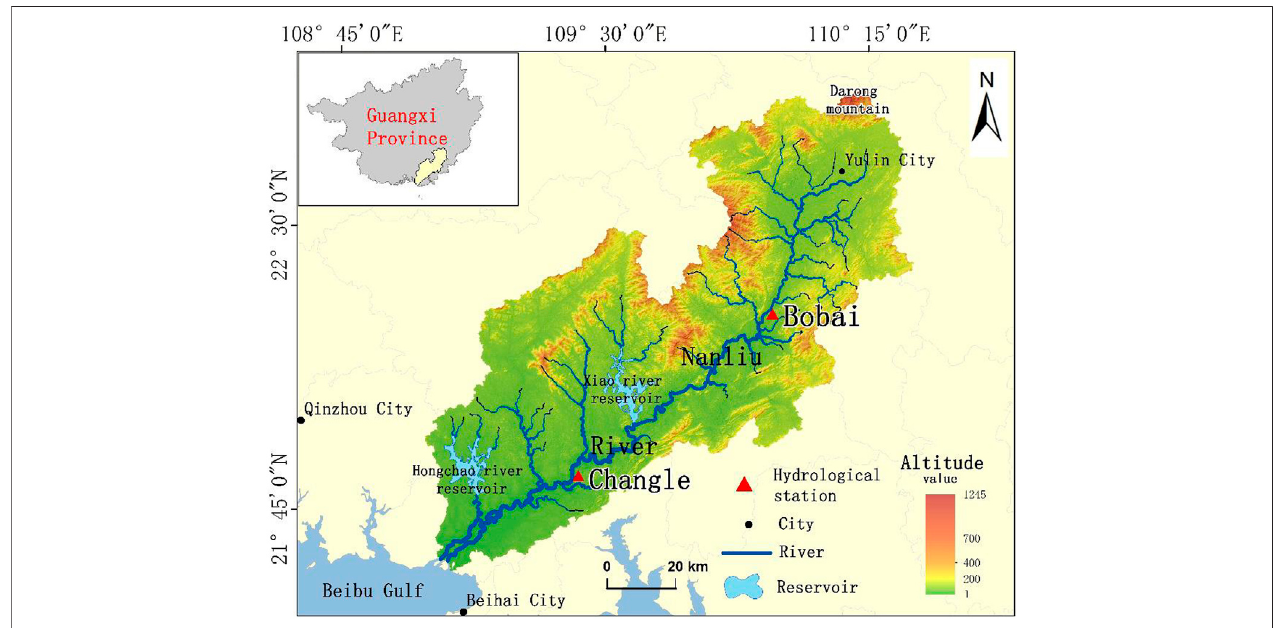
FIGURE 1 | Study area with the hydrological stations in the Nanliu River Basin.